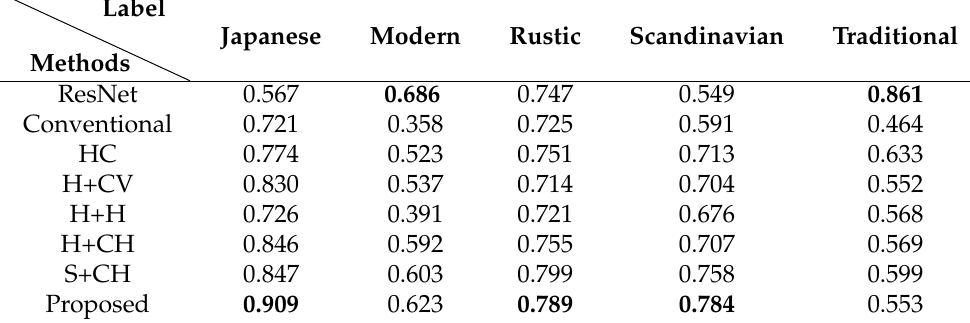
Table 3. F-measures of the test images of the methods.